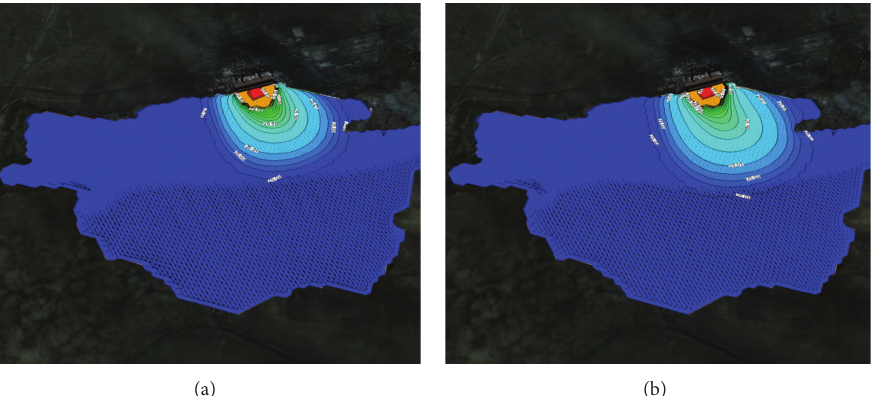
Figure 6: Outline and contours of temperature at 15 and 24 hours at the north-west wind after the launch of Ekibastuz SDPP-1 on the surface of the water and the side